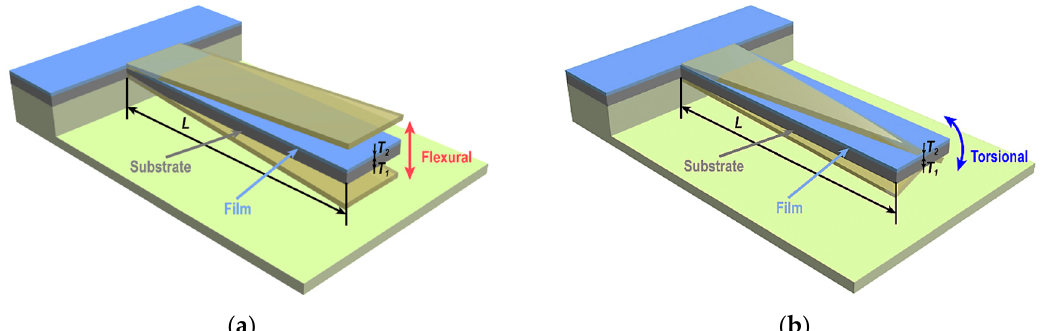
Figure 1. Sketch of the two-layered microcantilever made of an elastic substrate and coated ultrathin film performing ( a ) flexural and ( b ) torsional oscillations.